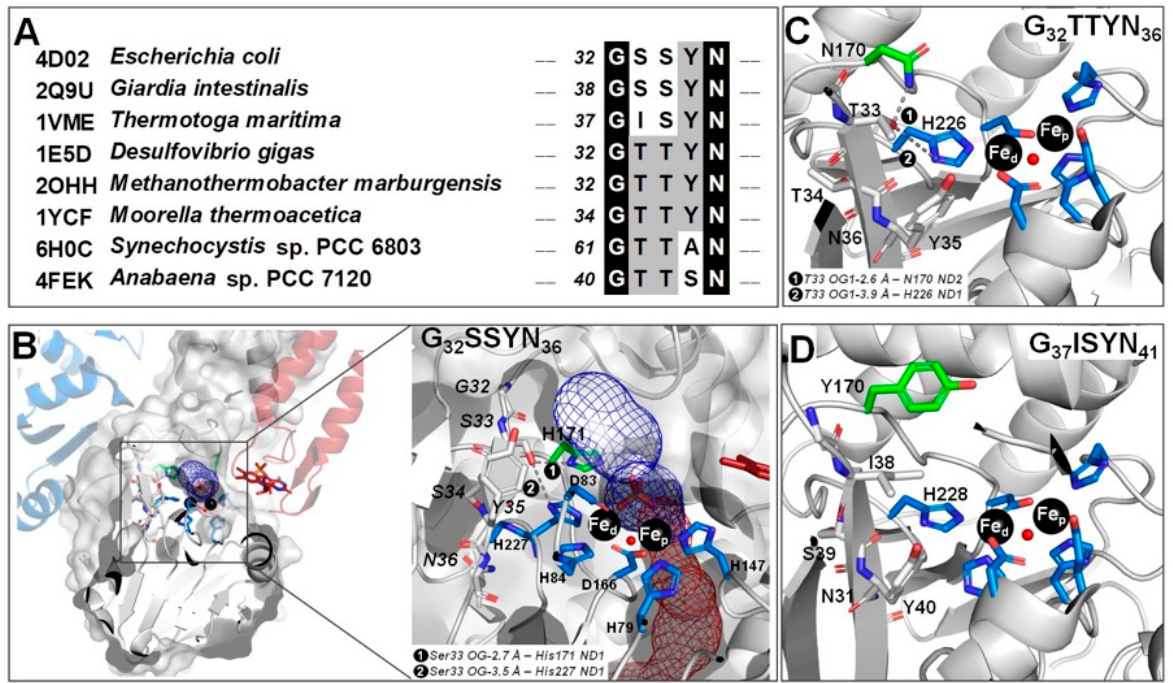
Figure 1. The motif -G[S,T,I][S,T]Y[A,S]N- in FDPs. ( A ) -G[S,T,I][S,T]Y[A,S]N- motif of the FDPs of which the structures have been determined; the respective PDB code is presented. ( B ) The different monomers of the E. coli FDP structure are presented in different colors (gray, red and blue) and the catalytic center and the -GSSYN- motif region (in gray) have been amplified for better clarity. The coordinating phosphate is displayed using sticks with the phosphorus in orange and the oxygen in red. The two channels identified in the E. coli FDP structure (blue mesh—small channel, red mesh—long channel) were determined using MOLE [28] and the FMN is represented as red sticks. ( C ) Representation of D. gigas FDP (1E5D) catalytic center. ( D) Representation of Thermotoga maritima FDP (1VME) catalytic center. ( A – C ) The iron atoms of the catalytic center are represented as black spheres (Fe D —distal; Fe P —proximal); the ligands of the catalytic center are represented in blue; the -G[S,T,I][S,T]YN- motif is represented in gray; His171 from E. coli FDP, which is located in the lower part of the small channel, is represented in green, as well as the corresponding residues in D. gigas FDP (Asn170) and T. maritima FDP (Tyr170). The distances of the different residues in the motif from other residues are presented. Most of the residues of the motif are not accessible to the solvent, mainly due to the region between residues 13 to 20, which includes the β 3 -sheet and a loop. Importantly,